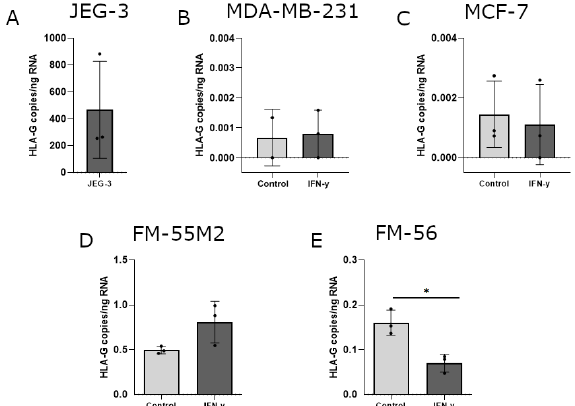
Figure 5. HLA-G mRNA expression in cancer cell lines stimulated with interferon (IFN)-γ. The effect of IFN-γ on the transcriptional level of HLA-G was determined by digital droplet (dd)PCR and presented as number of HLA-G copies per amount of RNA. ( A ) JEG-3 control cells with high HLA-G expression. ( B ) MDA-MB-231 cells treated with 30 ng/mL IFN-γ for two days. ( C ) MCF-7 cells treated with 24 ng/mL IFN-γ for two days. ( D ) FM-55M2 cells treated with 30 ng/mL IFN-γ for two days. ( E ) FM-56 cells treated with 30 ng/mL IFN-γ for two days. Shown are mean ± SD, each dot represents one sample. * p < 0.05 (Student’s unpaired t-test with Welch’s correction). Int. J. Mol. Sci. 2020 , 21 , x FOR PEER REVIEW